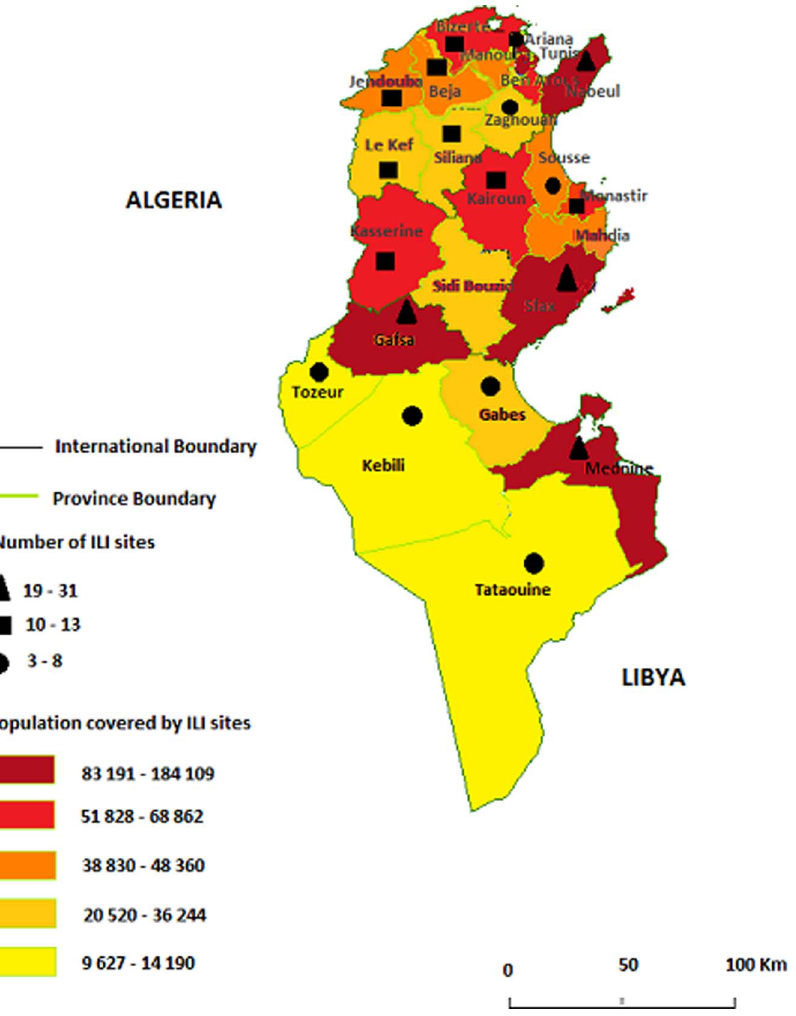
Figure 1. Map of ILI sites and population covered by ILI sites in different Tunisian governorates in 2009–2010 season.